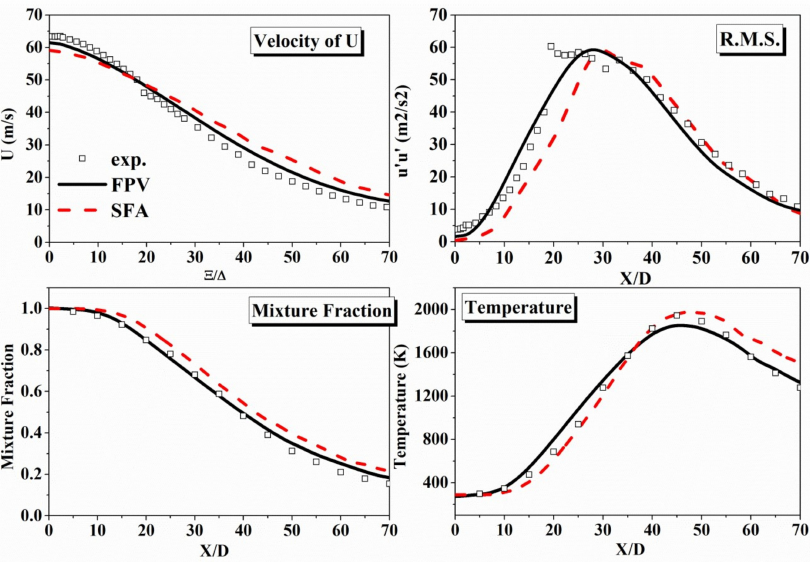
Figure 6. Comparison of key variables along the centerline (SFA—steady flamelet approach; FPV—flamelet/progress variable; R.M.S—root mean square).